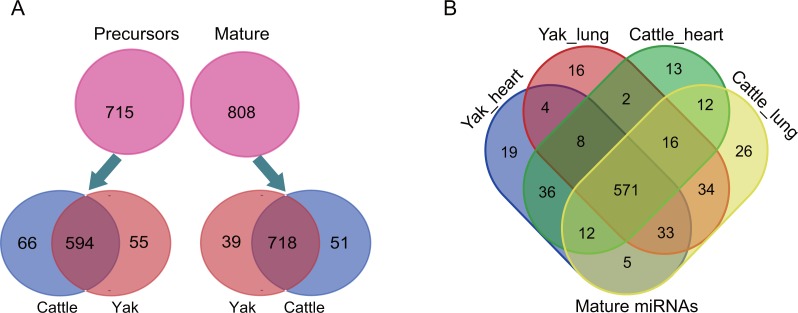
The overview of small RNA sequencing.(A) Mature miRNAs and miRNA precursors identified in this study. (B) Venn charts indicate expression patterns of mature miRNAs among each sample.